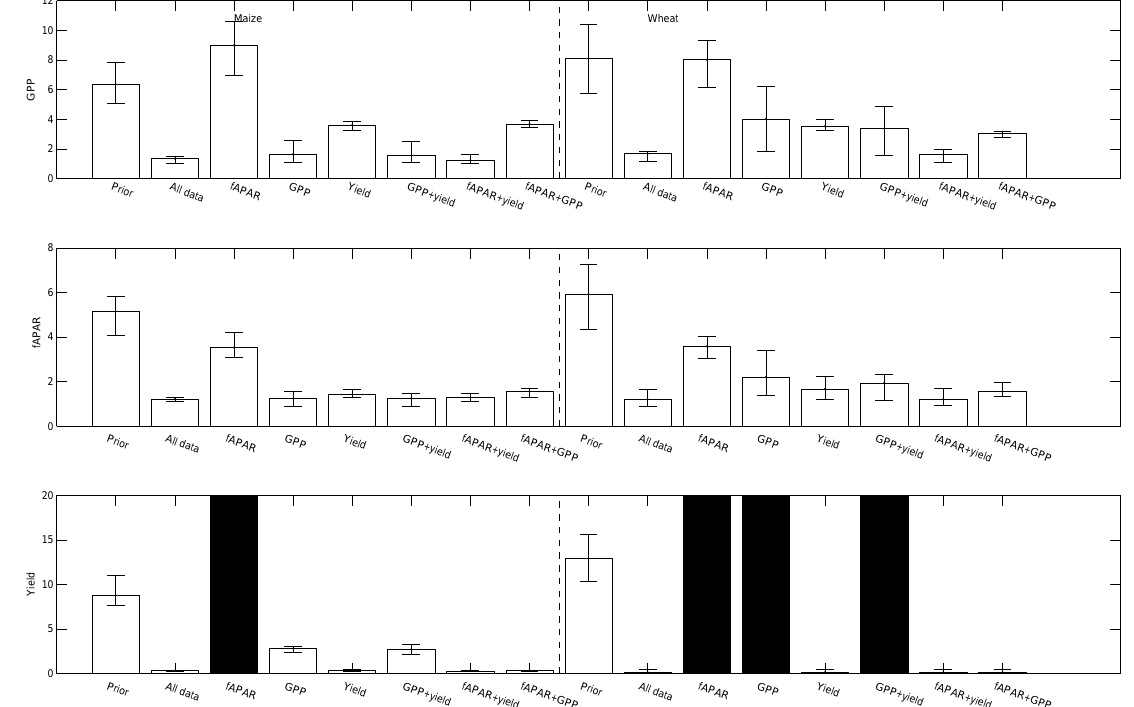
Figure 6. Model uncertainty, expressed as the difference between the upper and lower 95th confidence intervals for all model setups averaged across all wheat and maize sites. Error bars represent variation between sites. All values have been normalised. Black bars indicate models that do not reach